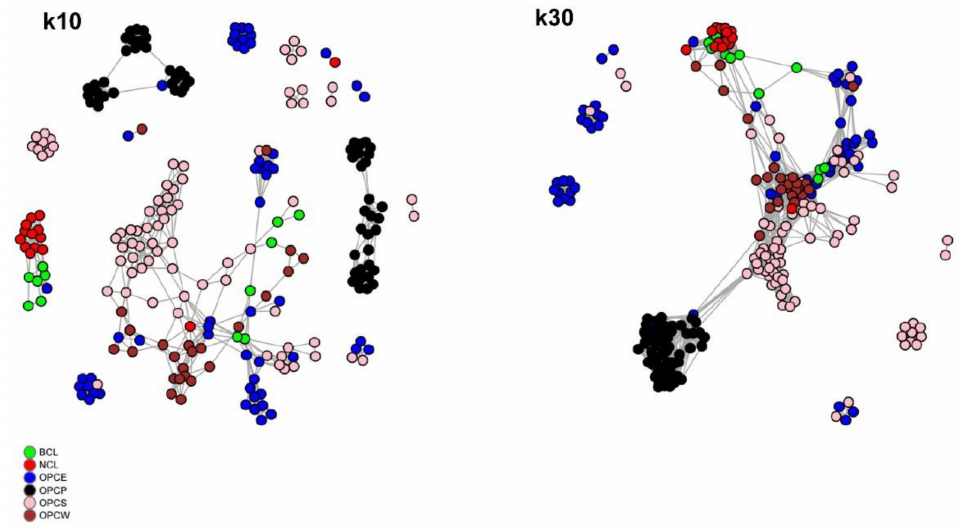
Figure 10. Visualisation of high-resolution population networks for 6 Creole sheep breeds. K-NN = 10 (left) investigated small-scale structures, K-NN = 30 (right) targeted large-scale structures and breeds are distinguished by node